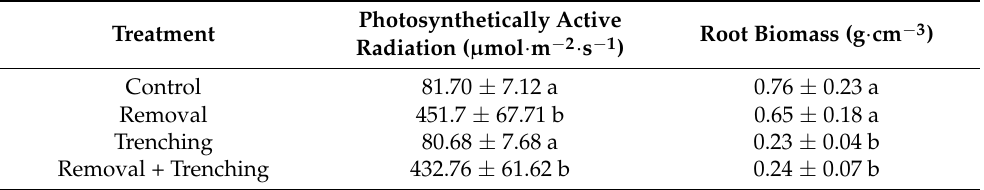
Table 1. Comparison of photosynthetic effective radiation and root biomass of roots under different treatments. Different letters (a, b) indicate significant difference ( p ≤ 0.05).